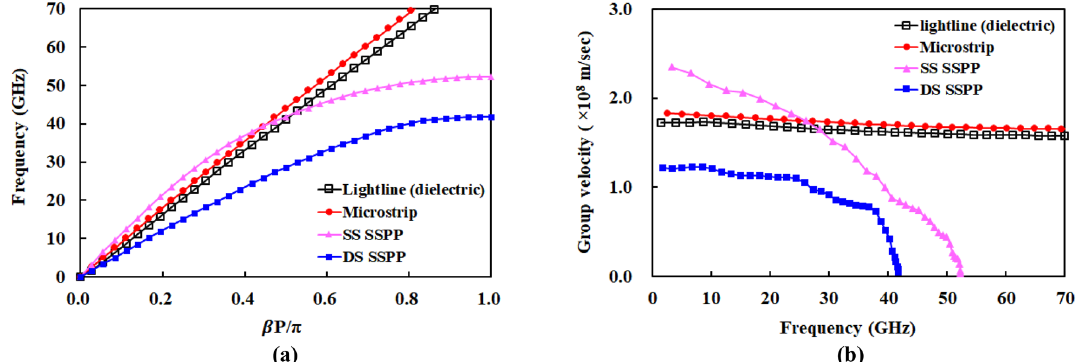
Figure 2. Dispersion curve and group velocity of lightline, microstrip, SS SSPP, and DS SSPP in the same dielectric substrate. ( a ) Dispersion curve. ( b ) Group